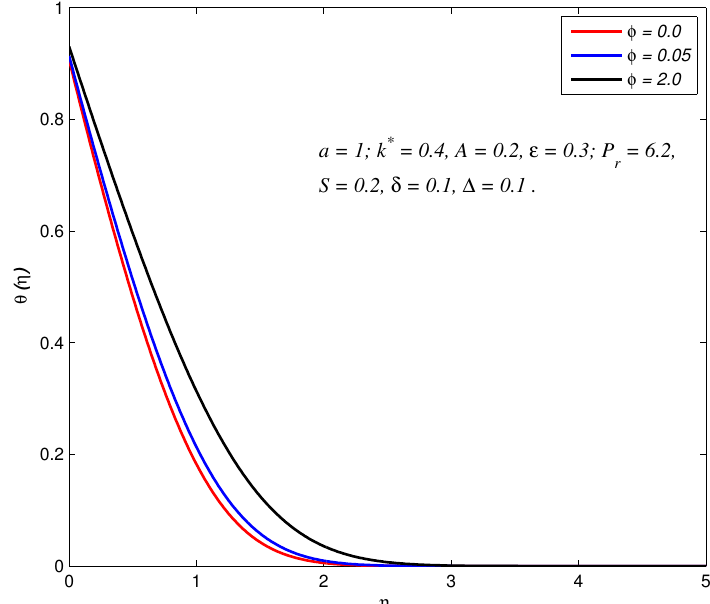
Figure 6. Temperature θ ( η ) profiles for different values of volume fraction coefficient φ